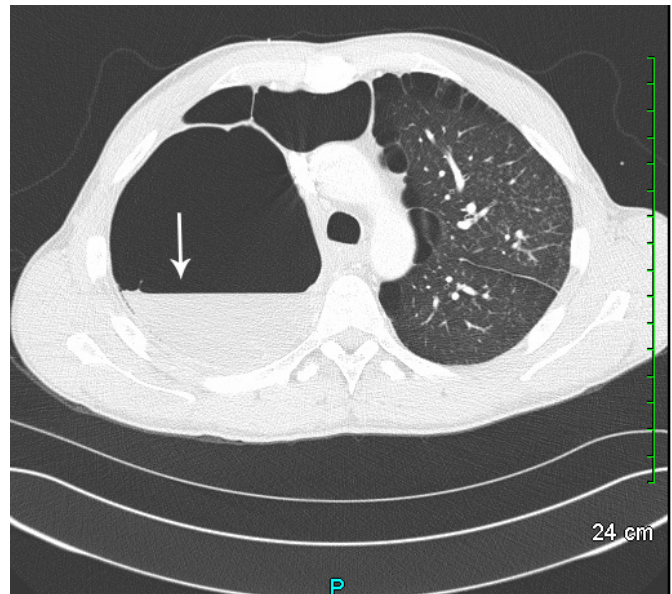
Figure 2. Coronal chest computed tomography demonstrating extensive bullous disease of the lungs with a prominent bulla in the right upper lobe containing an air fluid